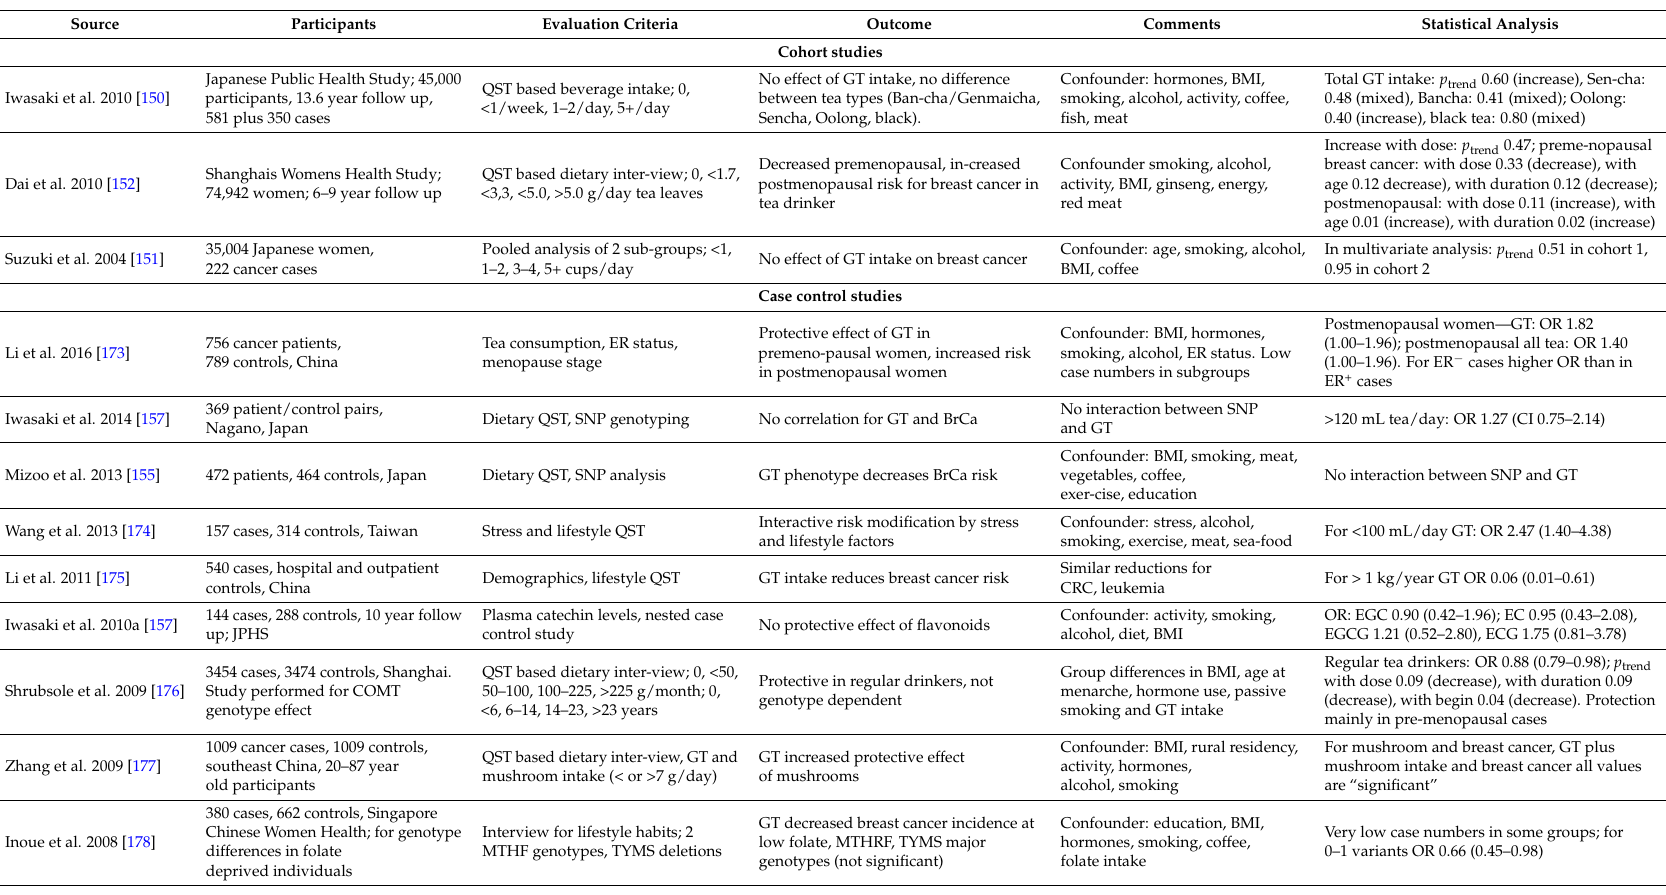
Table 4. Epidemiological studies for GT and breast